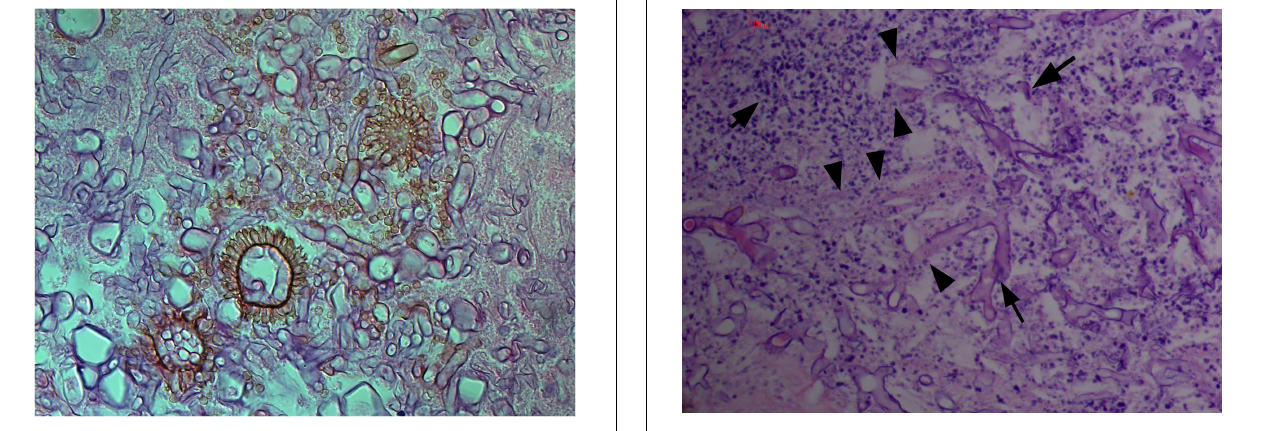
FIGURE 5 | Aspergillus heads in the cavernous sinus of rhino-orbital-cerebral mycosis (periodic acid-Schiff staining, original magnification × 400).